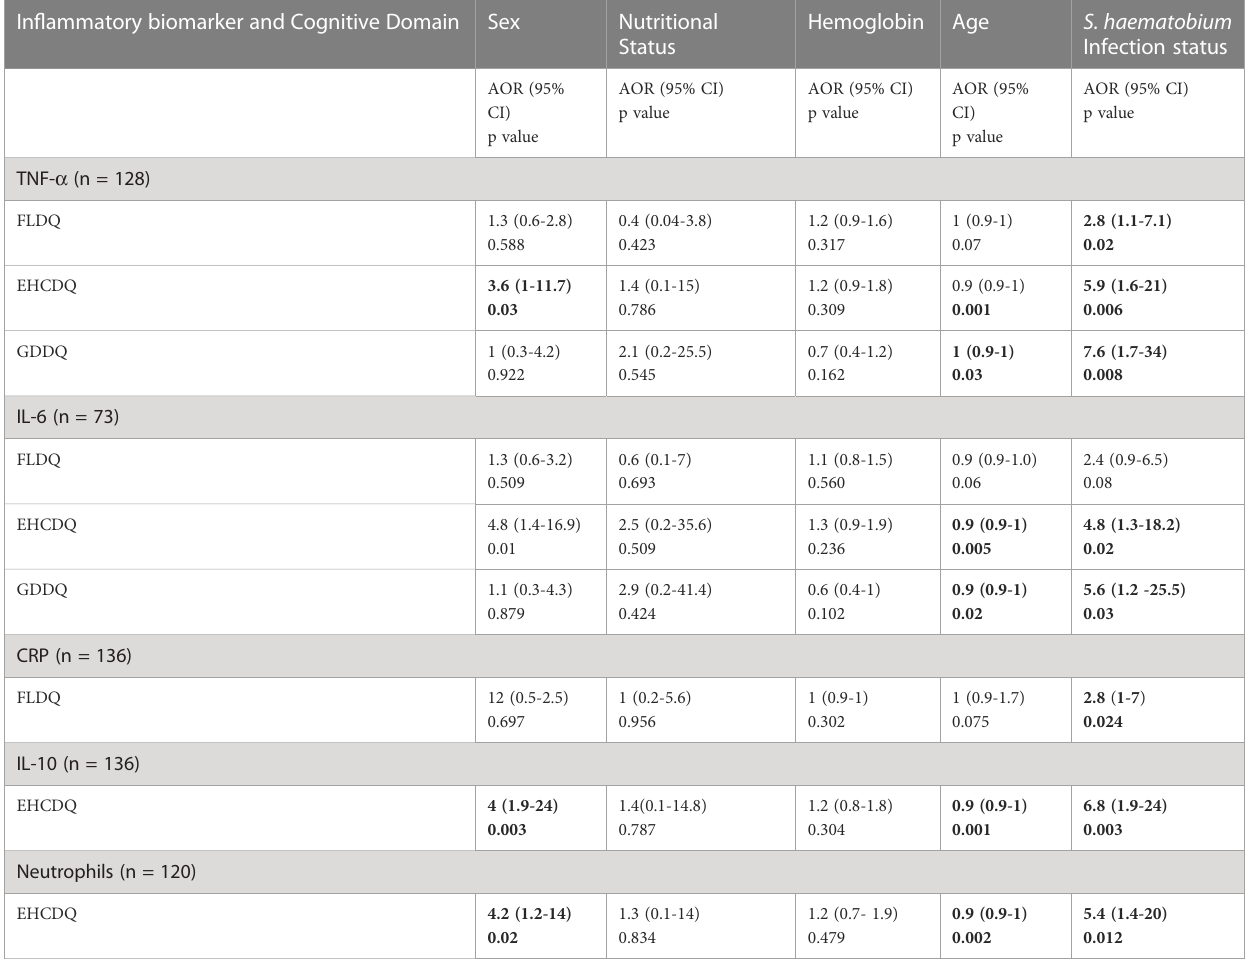
TABLE 3 Multivariate regression analysis of cognitive domains and explanatory variables. In fl ammatory biomarker and Cognitive